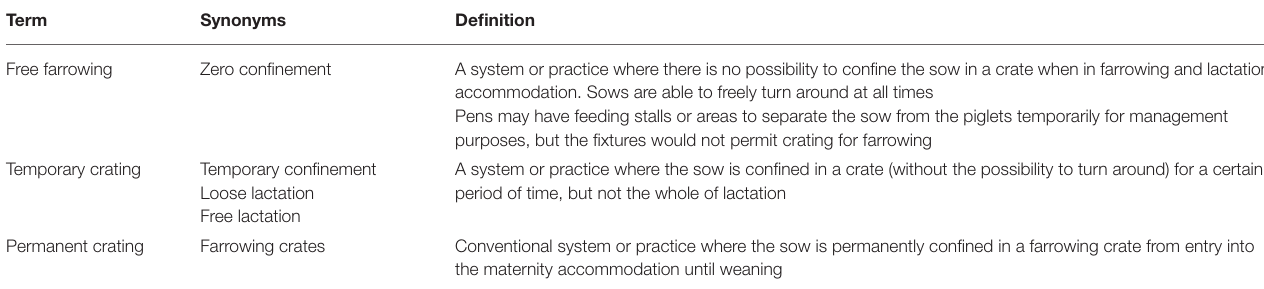
TABLE 1 | Definitions of indoor farrowing and lactation systems, practices, and terms.